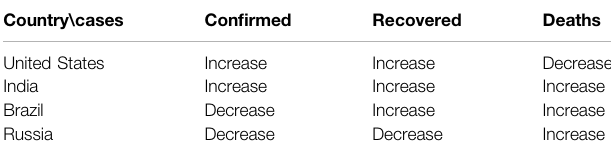
TABLE 6 | Summary of the forecasts for the next 15